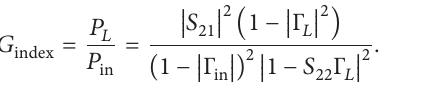
Figure 6: Simulated variation of powers due to the change of loads when 𝑍𝑠 is 50 Ω